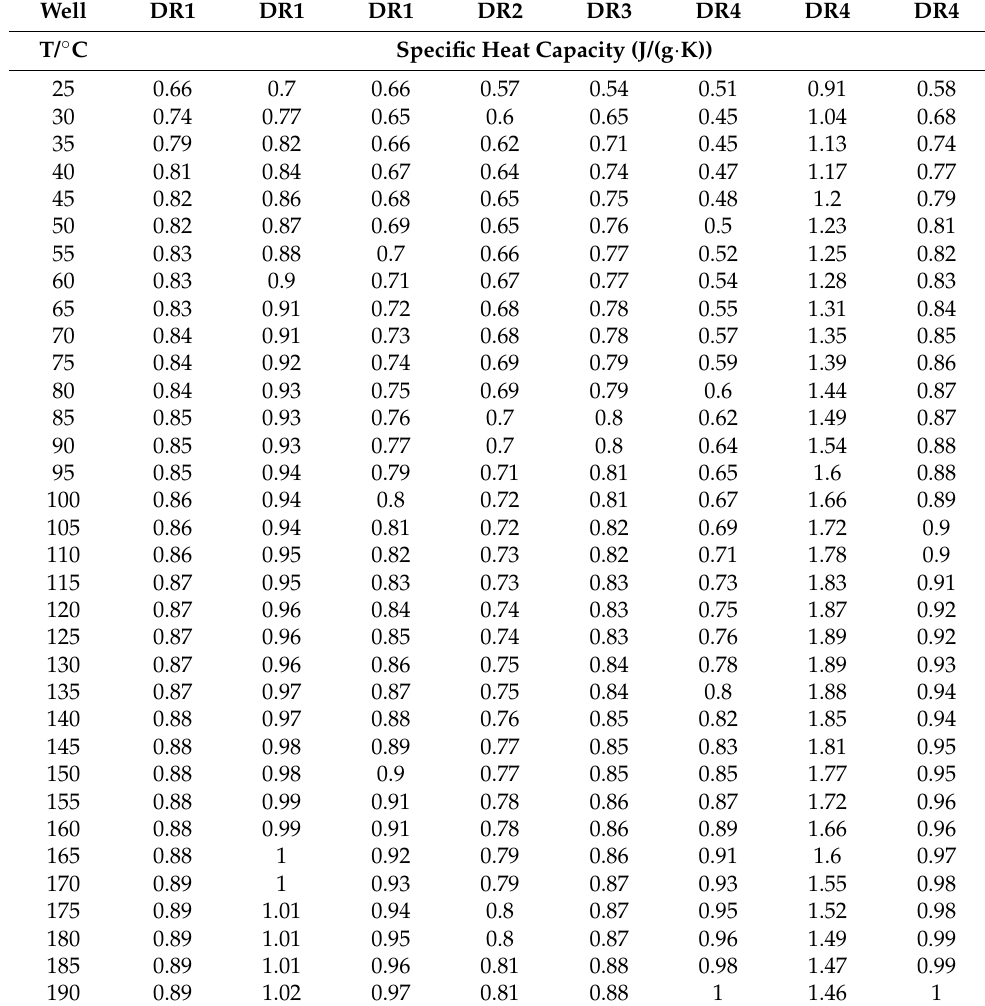
Table 5. Rock specific heat capacity test